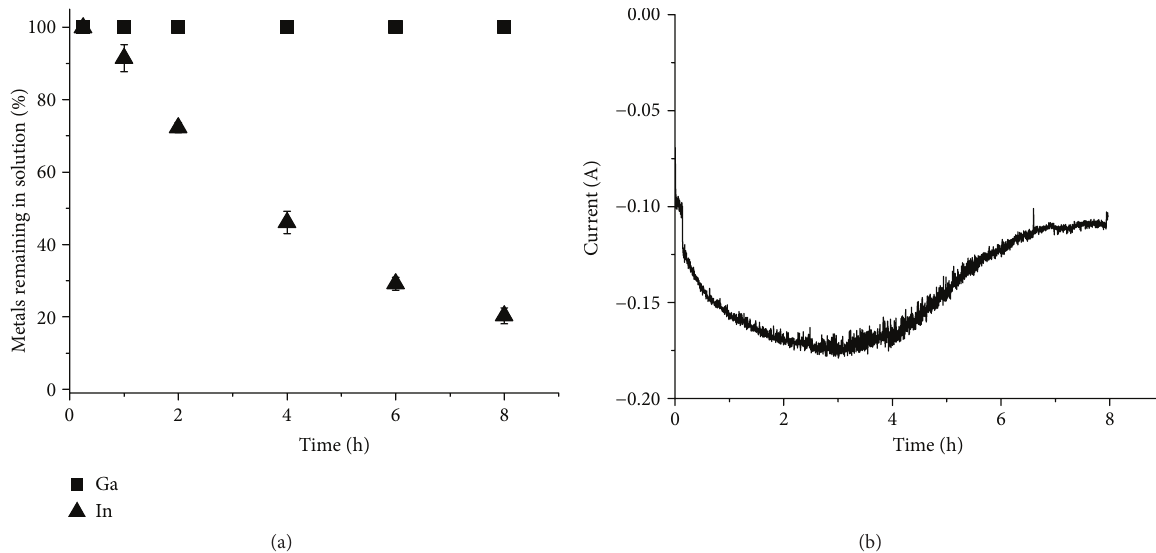
Figure 9: Electrochemical separation of indium from a solution prepared by directly dissolving real waste material in 3 M HCl with an addition of H 2 O 2 at 80 ∘ C (Solution 2). (a) The metal concentration in the solution relative to the original concentration as a function of time. (b) The current passed though the circuit as a function of time.